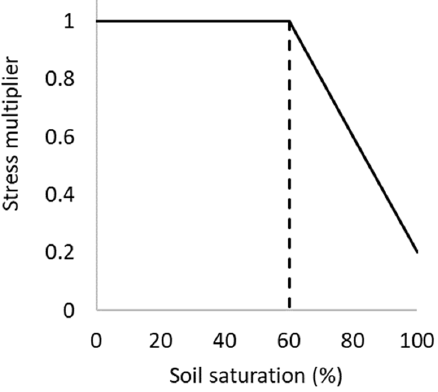
Figure 1 . APSIM waterlogging function with an inflection point (threshold value) of 60%.